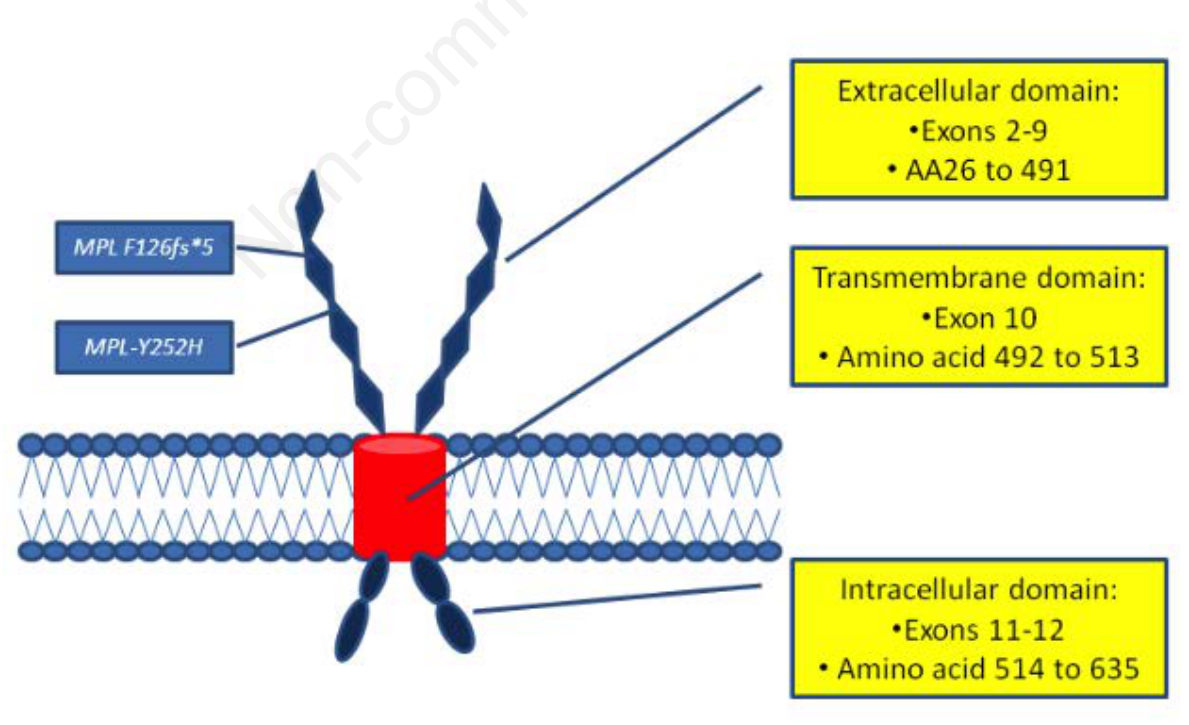
Figure 1. Structure of MPL receptor and location of the 2 reported mutations. Both mutations are in the extracellular